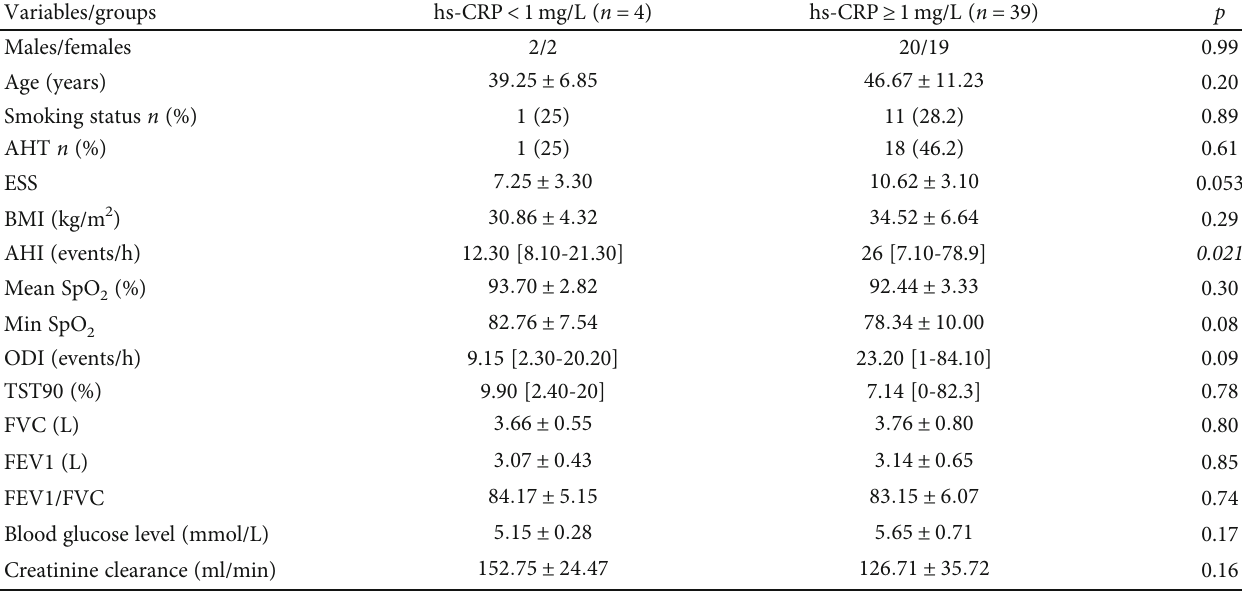
Table 3: Predictive factors of high serum levels of hs-CRP in patients with OSAHS: univariate analysis.